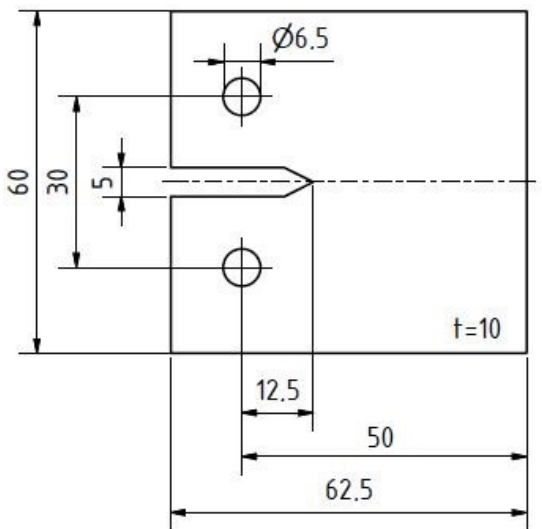
Figure 2: Geometric dimensions of the investigated compact tension specimen (dimensions in